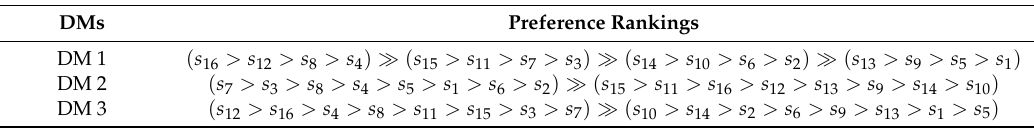
Table 6. DMs’ strength of preference